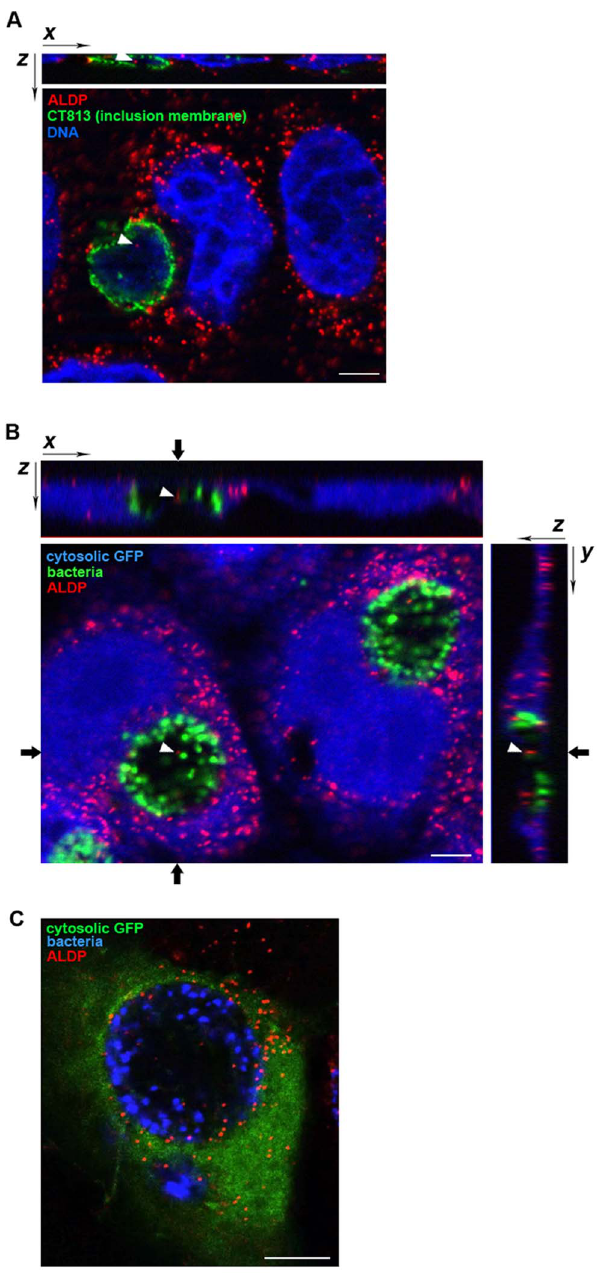
Figure 1. Peroxisomes are translocated into the Chlamydia inclusion during infection. A- HeLa cells were infected with C. trachomatis L2 for 20 h. The inclusion membrane was labeled with an anti-CT813 antibody (green), peroxisomes with an anti-ALDP antibody (red) and bacterial and nuclear DNA with Hoechst (Blue). A single ApoTome x-y section is shown in the central image. The z-x projection on the top shows the peroxisome indicated by a white arrowhead in the x-y image. Scale bar: 5 m m. B- HeLa cells were transfected with cytosolic GFP (shown in blue) to illuminate the entire cell except for the Chlamydia inclusion and were infected with C. trachomatis L2 for 20 h. Bacteria were labeled with an anti-Hsp60 antibody (green) and peroxisomes with an anti-ALDP (red). A single ApoTome x-y section is shown in the central image. z-x and z-y projections on the top and on the right side, respectively, are centered on the peroxisome indicated by a white arrowhead. Scale bar: 5 m m. C- One optical section from the stack of images shown in Movie S1. Cells were prepared as in Figure 1 B; the colors are different: bacteria are in blue, peroxisomes in red, GFP in green.